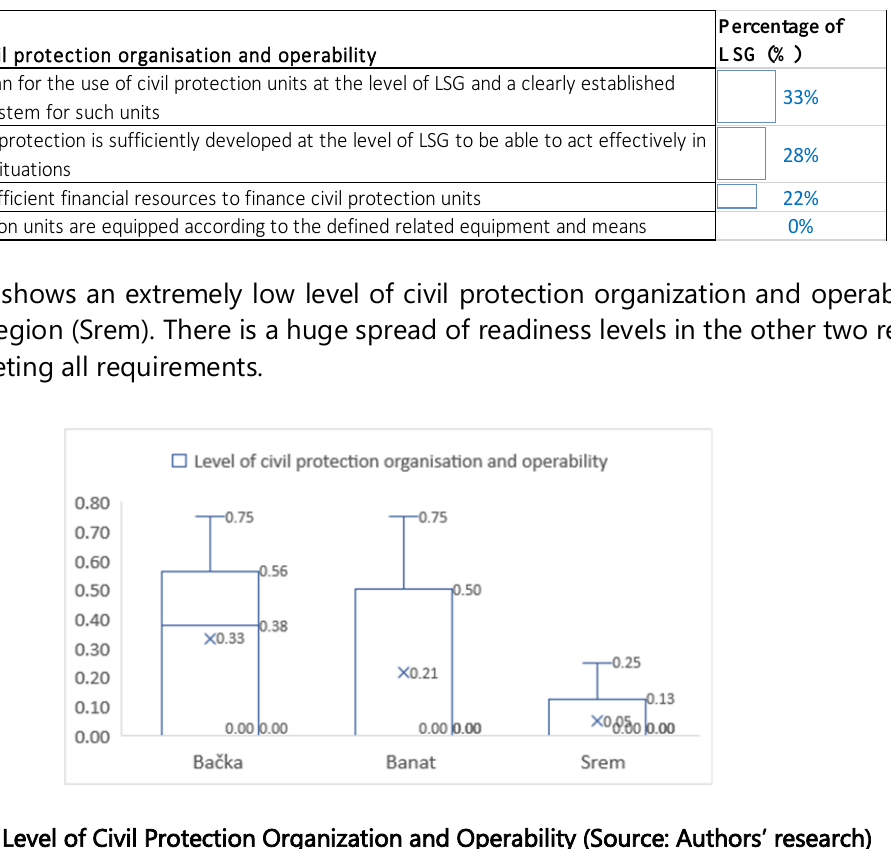
Figure 3: Level of Civil Protection Organization and Operability (Source: Authors’